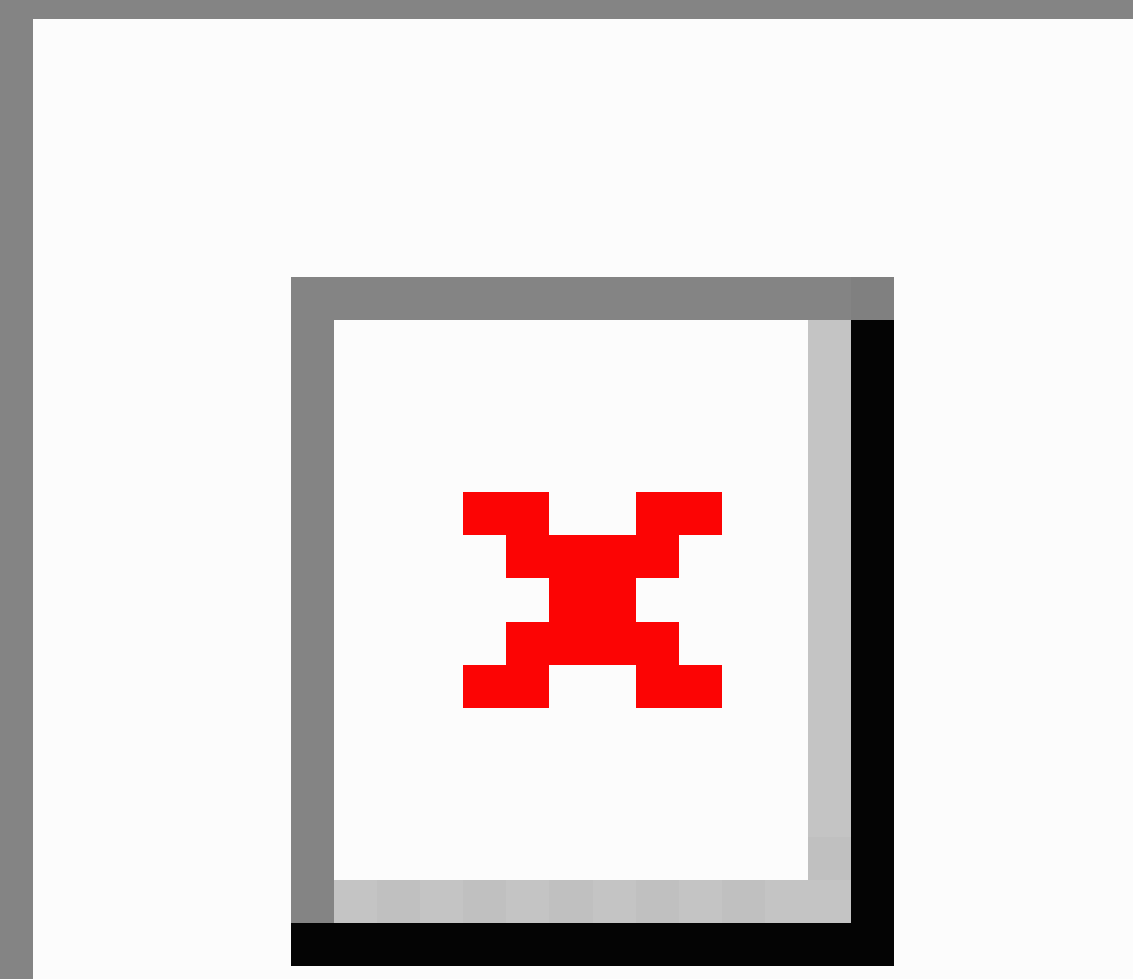
Figure 1. Summary of the mediation analysis with the Working Alliance Inventory task subscale during cognitive behavioral treatment for generalized anxiety disorder delivered by videoconference (N=46). b : unstandardized beta coefficient; IUS: Intolerance of Uncertainty Scale; PSWQ: Penn